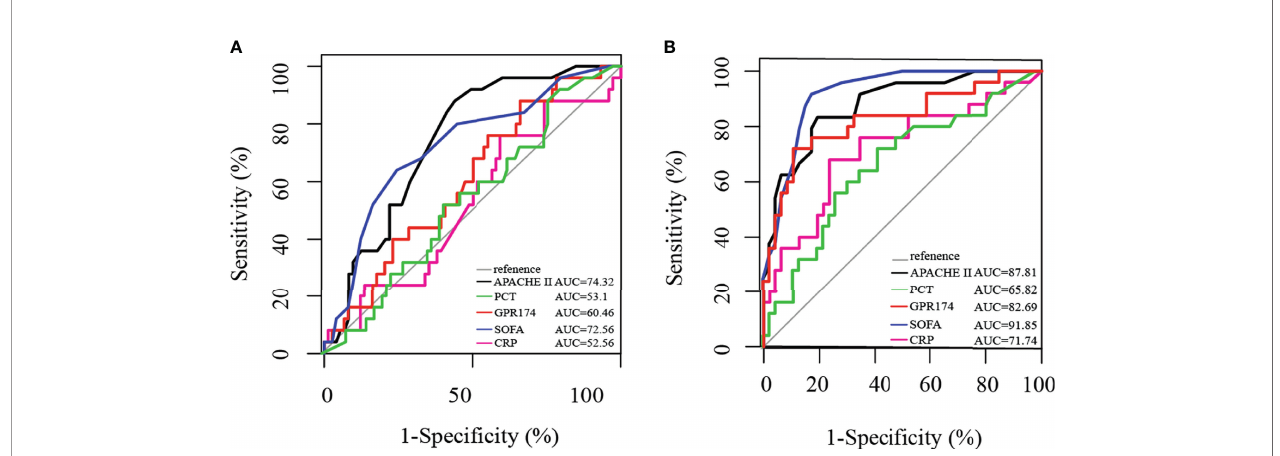
FIGURE 4 | Receiving operating characteristic (ROC) curve for predicting 90-day mortality in septic patients. (A) ROC of APACHE II score, PCT, GPR174 mRNA, SOFA score, and CRP for mortality at ICU admission. (B) ROC of APACHE II score, PCT, GPR174 mRNA, SOFA score, and CRP for mortality at Day 7 after ICU admission.